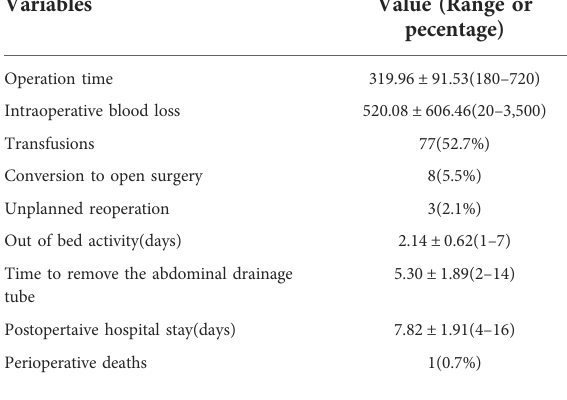
TABLE 2 Perioperative data ( n